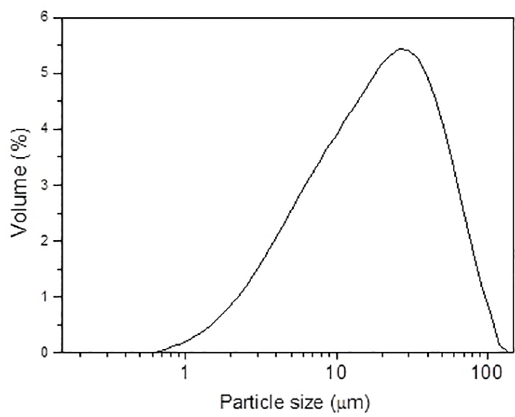
Figure 5. Particle size distribution curve of kaolin.